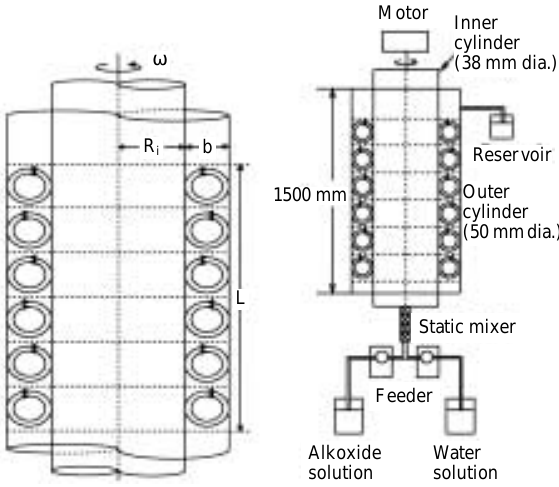
Fig. 1 Schematic diagrams of Couette-Taylor vortex flow and